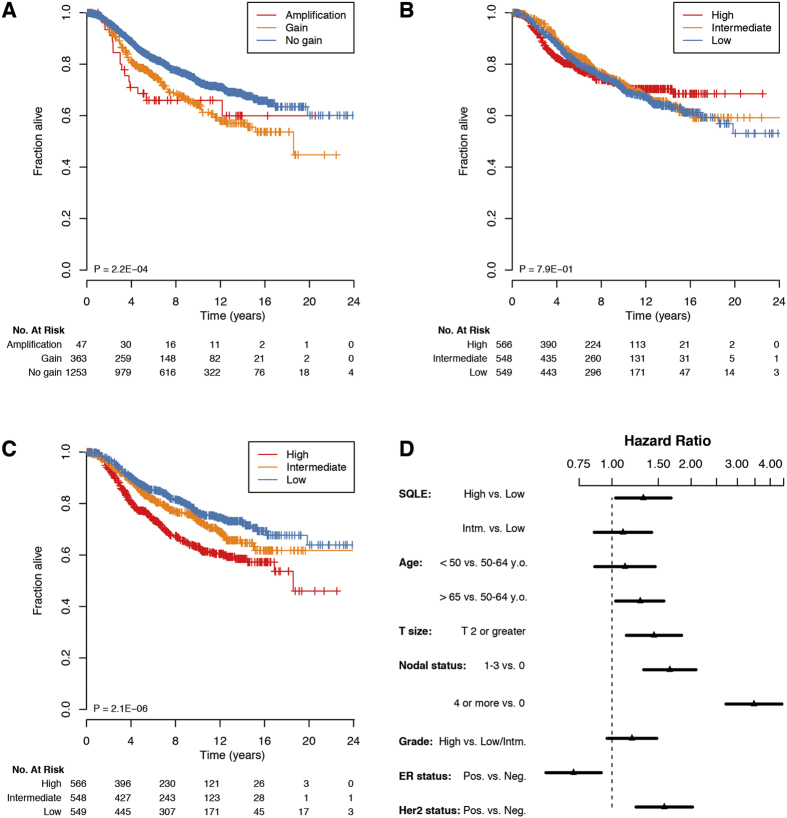
SQLE high expression is independently associated with unfavorable prognosis in breast cancer.Patients affected by tumors bearing chromosome 8q24.13-q24.21 (the region encompassing SQLE and MYC) gains or amplifications are characterized by poorer overall survival (OS), (A). However, whilst MYC expression levels have per se no prognostic value (B), SQLE overexpression is not only associated with worse OS by univariable analysis (C), but also maintains its independent prognostic value in a Cox proportional hazard model, including all classical clinical and pathological parameters, as shown in the forest plot depicted in panel (D) (HRs represented by black triangles and 95% CIs showed as horizontal black lines). Data are from the METABRIC set. P values in the bottom left area of Kaplan-Meier curves are obtained using the log-rank test. Panel D abbreviations: Intm. = Intermediate, y.o. = years old, NPLN = number of positive lymph nodes.